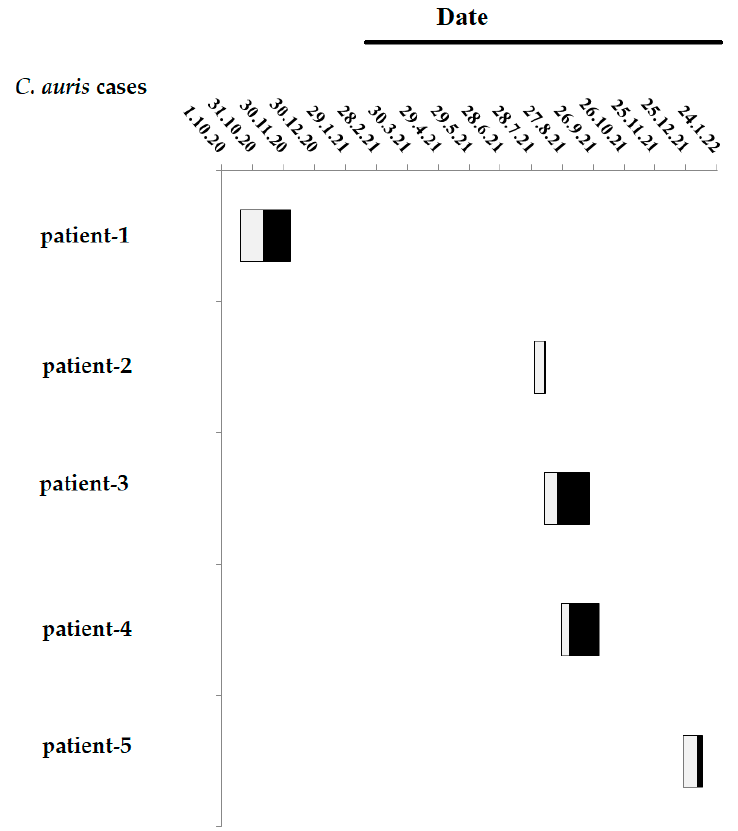
Figure 1. Timeline of the five C. auris cases in the ICU. The boxes denote the length of stay (LOS) of C. auris cases in the ICU prior (grey boxes) and post to (black boxes) the isolation of C. auris . The black line denotes the period that the ICU has been functioned as a COVID-19 ICU. Table 2. Antifungal susceptibility of C. auris clinical